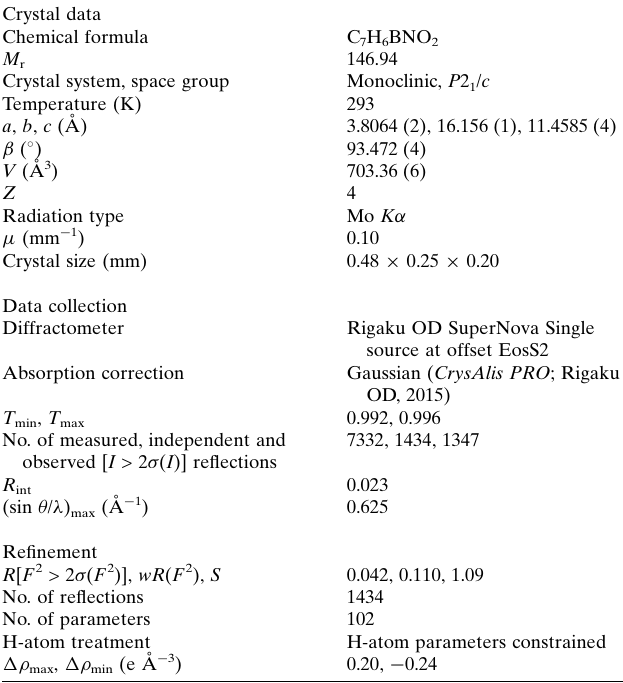
Table 2 Experimental details. Crystal data Chemical